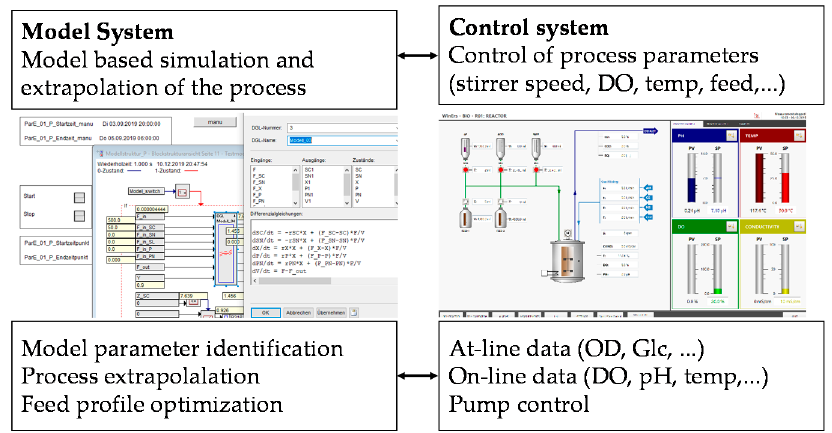
Figure 3. Schematic overview of the used control system setup. Model system and process control are realized together in one control system.